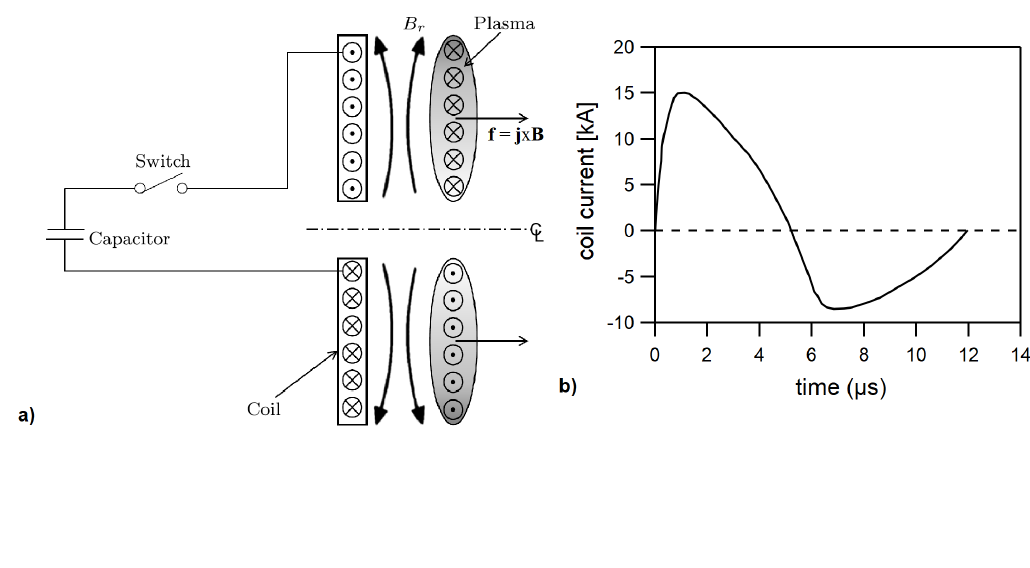
Figure 1. ( a ) Schematic showing the basic operation of a planar IPPT, where the Lorentz body force f in the axial direction arises from the interaction between the azimuthal plasma current density j = and the radial magnetic field B = B r ˆ r . ( b ) Sample discharge current from the PIT MK Va for one of the nine parallel coils (from [9]).